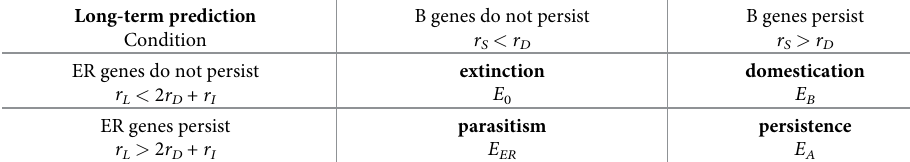
Table 3. Conditions determining which classes of prophage genes persist